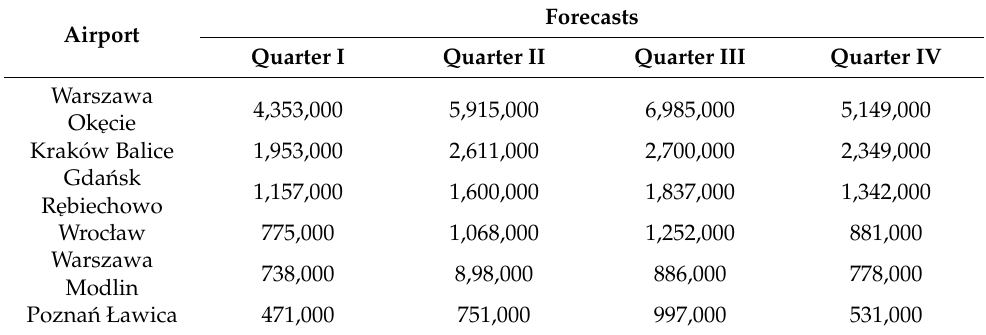
Table 4. Forecasts for individual quarters of the year 2020—the method of seasonality